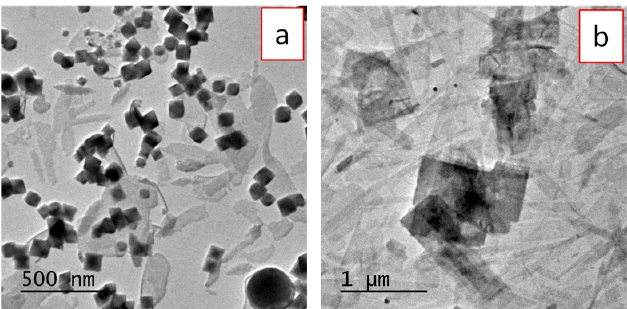
Figure 3. TEM micrographs of precipitates obtained after treating, at 50 °C for 15 h, EG/H 2 O solutions containing Lu(NO 3 ) 3 ·6H 2 O (0.2 M) and NaBF 4 (0.18 M) at different EG/H 2 O ratios: 50/50 ( a ) and 0/100 ( b ).